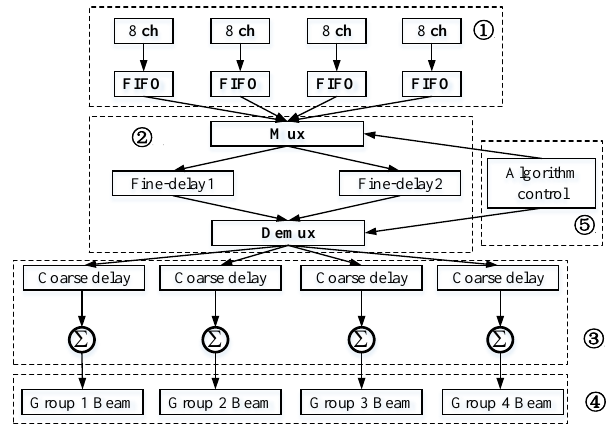
Figure 4. Fine delay scheduling model diagram in the multi-scan group.